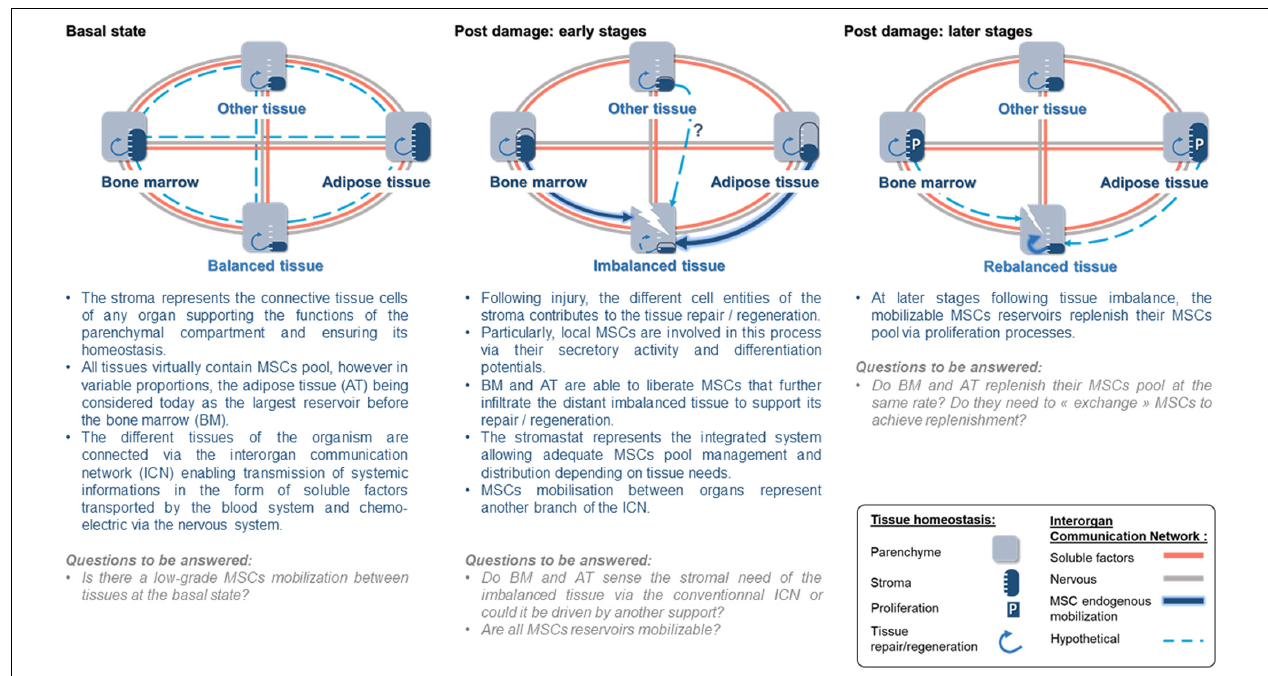
FIGURE 2 | The stromastat hypothesis within the interorgan communication network during basal and after tissue